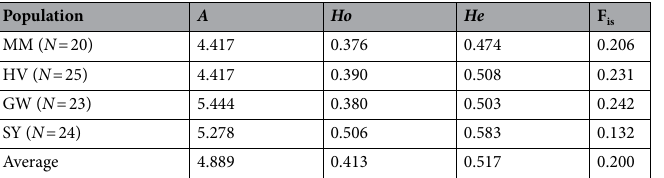
Table 4. Detailed genetic diversity parameters were identified at 36 simple sequence repeat (SSR) in four populations (MM, HV, GW, SY) of Chamaecyparis formosensis. N : the number of individuals, A : number of alleles, Ho : observed heterozygosity, He : expected heterozygosity, F is : inbreeding coefficient. When Ho < He , F is > 0, indicating that the population is inbreeding 67